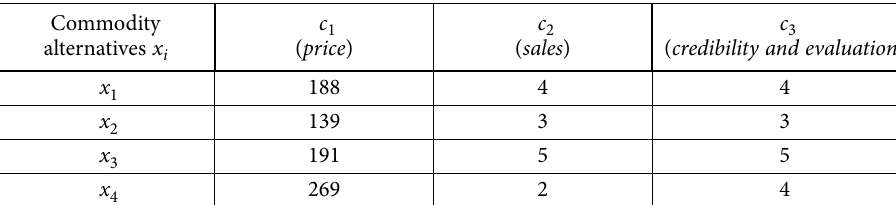
Table 2. Decision